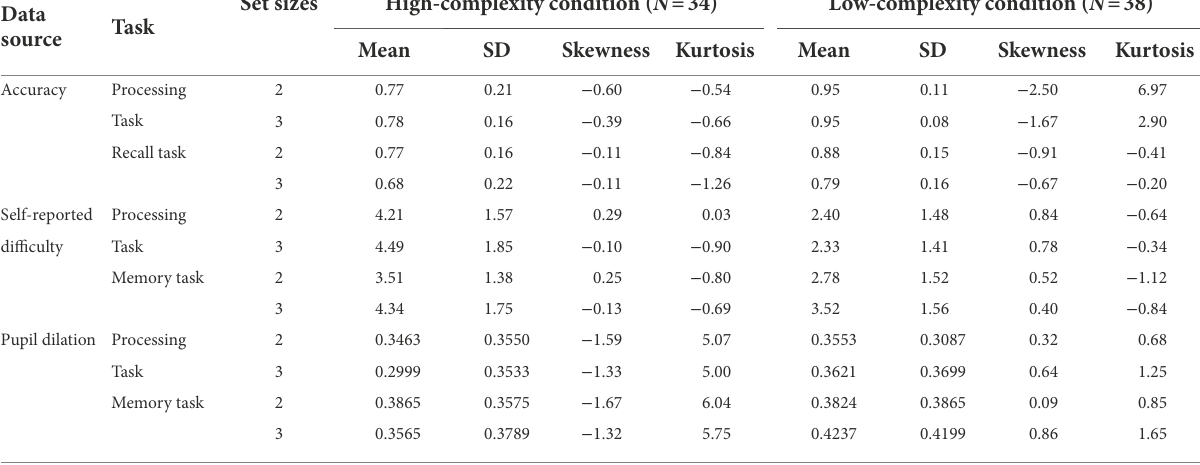
TABLE 1 Descriptive statistics of performance measurement, subjective measurement and physiological